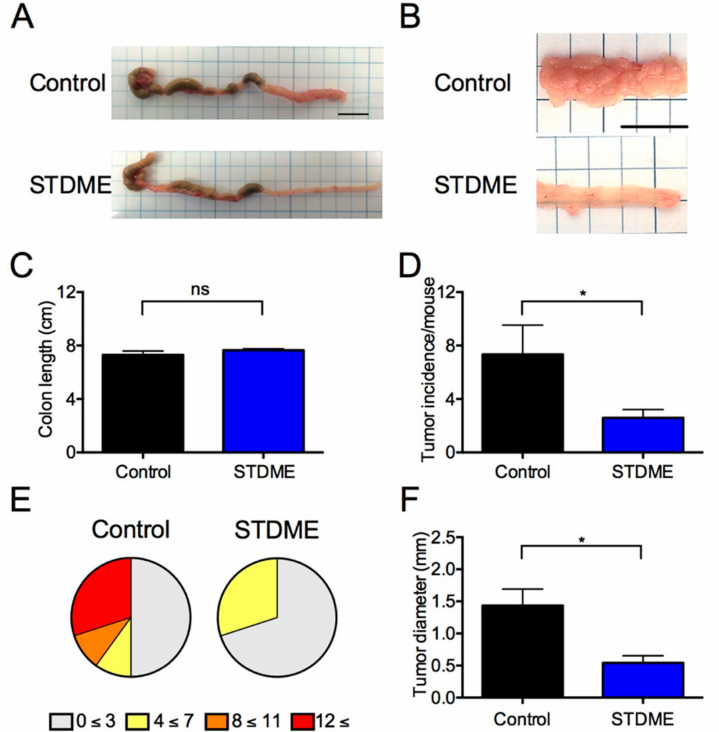
Figure 2. An STDME diet protects against AOM/DSS-induced CAC. ( A – D , F ) Representative pictures of colon ( A ), macroscopic polyps in the distal and mid-colons ( B ) and quantification of colon length ( C ) from STDME-fed mice compared with control mice; ( D – F ) The number of macroscopic polyps ( D , E ), and tumor diameter ( F ) were quantified. Data are presented as mean ± SEM and were assessed by a Mann-Whitney U -test. * p < 0.05; ns = not significant; n = 10/group. Each scale bar indicates 10 mm. STDME, selenoneine-containing tuna dark muscle